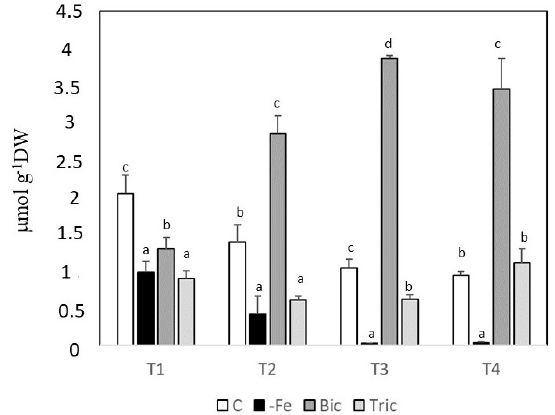
Figure 5. Apoplastic Fe concentration ( μ mol g − 1 DW) in roots of plants grown in control conditions (C), direct iron deficiency conditions (–Fe), and under induced Fe deficiency in the presence of bicarbonate (Bic) or alkaline organic buffer (Tric). T1, T2, T3, and T4 correspond to sampling at 1, 3, 5, and 7 days. Data are the means ± SE (standard error) ( n = 5). Different letters indicate statistical differences ( p < 0.05) within each treatment.